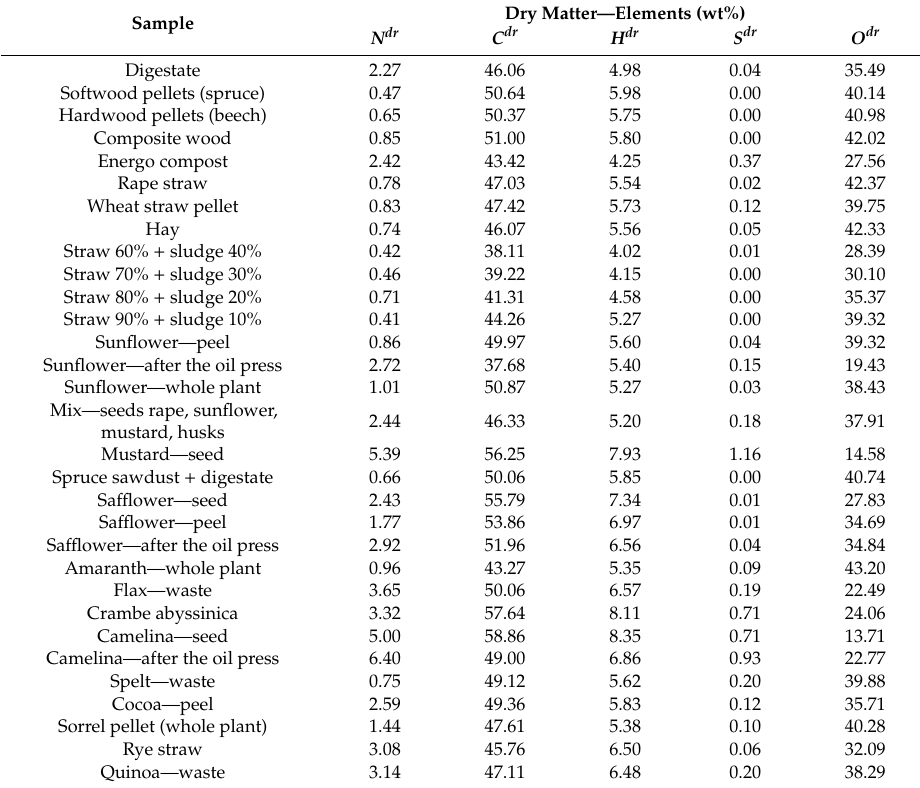
Table 8. Percentages of carbon, nitrogen, hydrogen, sulfur, and oxygen in the dry matter.